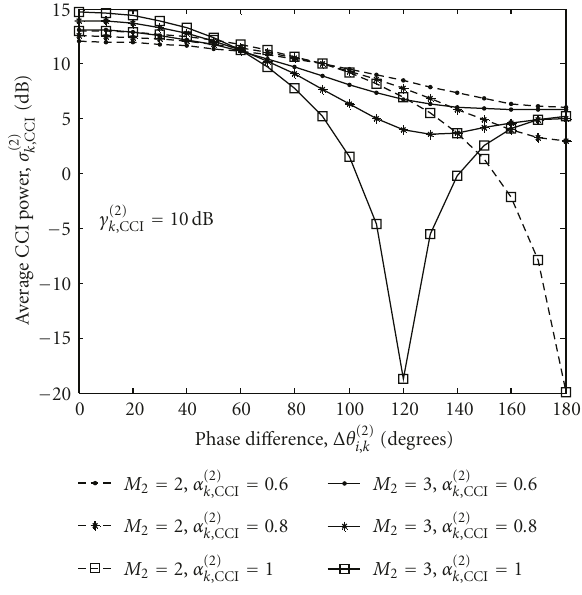
Figure 2: Average CCI power according to Δ θ (2)